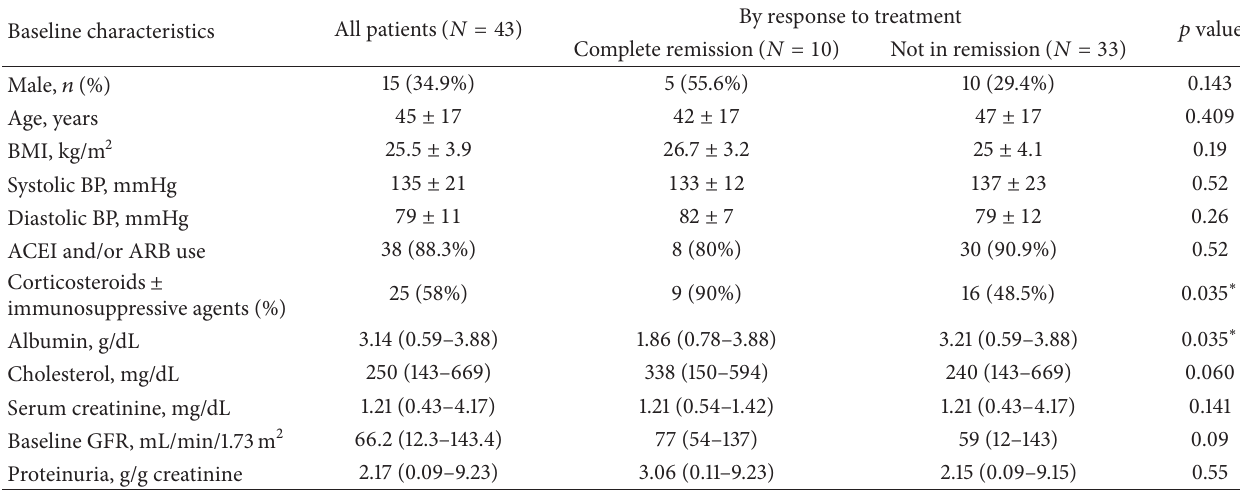
Table 1: Baseline characteristics according to remission status at